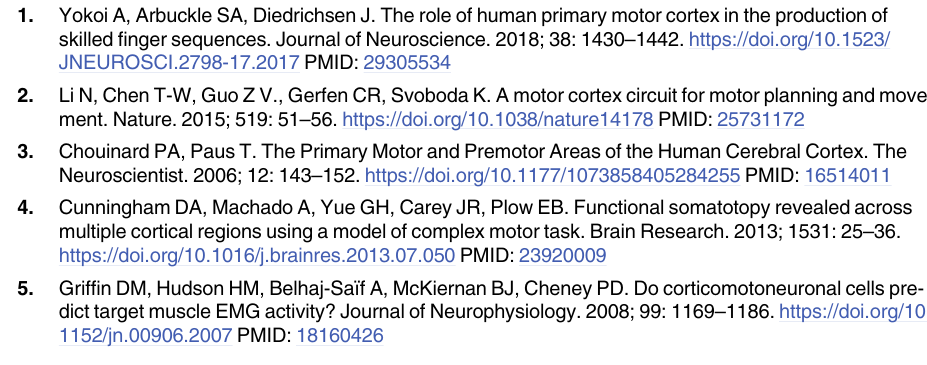
S10 Fig. Equi-representational body part modules. For each ROI, different modules are rep- resented by different colors. Each module was determined on the basis of an equal number of surface vertices that contributed to the body part nodes. Note that the colors only define a clus- ter of nodes within one graph, and any correspondence of colors between graphs is purely accidental. The whole-body graph layout is presented at the outmost right indicating the node-body part